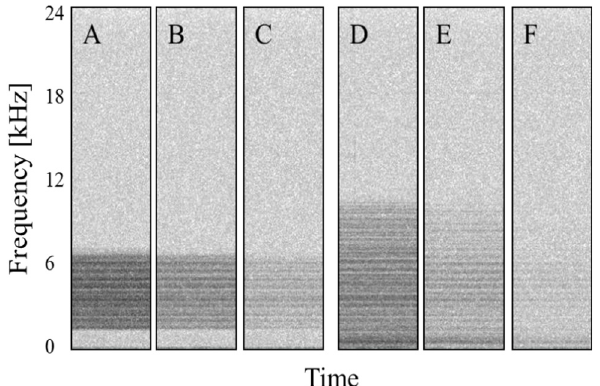
Fig 2. Noise stimuli. Spectrograms (1024 point Hamming window, 75% overlap, 11.7 Hz frequency resolution) of noise playback stimuli recorded during trials. Treatments A – C had a bandwidth of 5 kHz. Treatments D – F had a 10 kHz bandwidth. Harmonic structure is due to frequency response of the playback system.